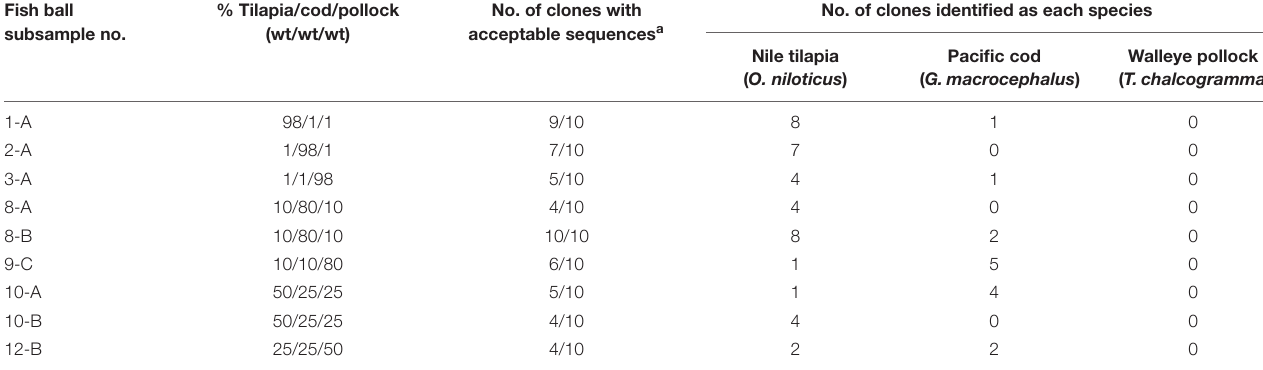
TABLE 4 | Sequencing results for fish ball subsamples that underwent PCR cloning and full DNA barcoding after failing standard full barcoding. Fish ball subsample